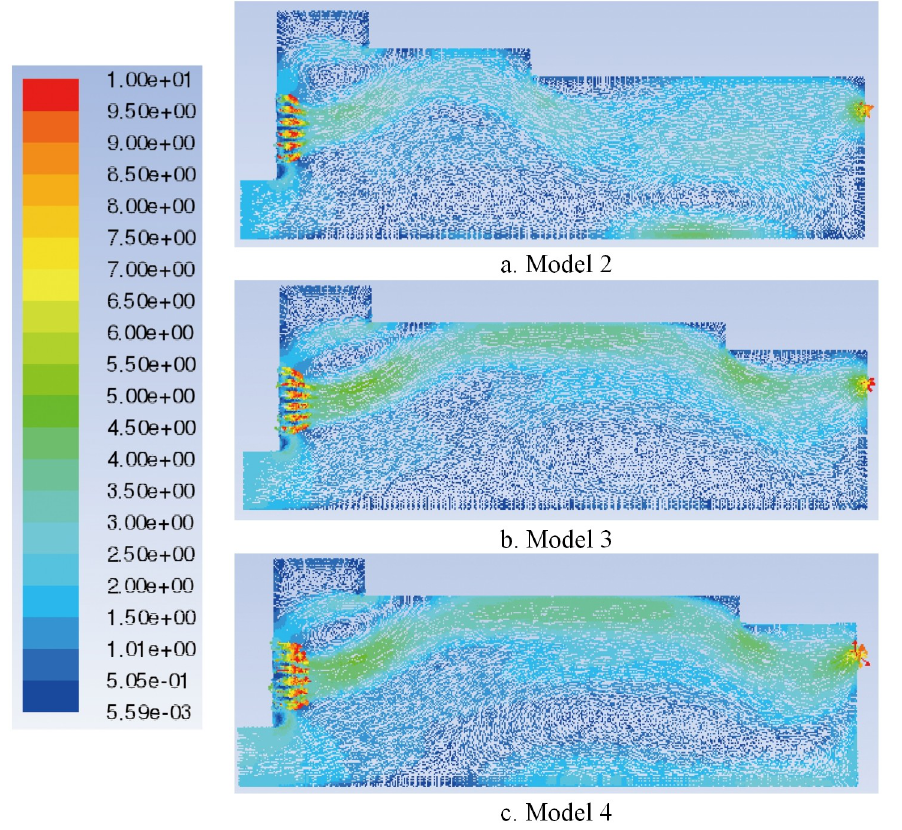
Fig 14. Flow field velocity vector of different paver